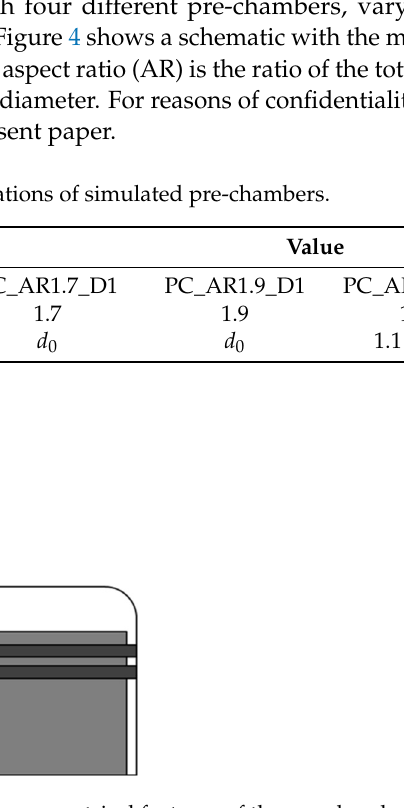
Figure 3. Detail of grid refinement in the spark plug region. Table 3. Mesh properties for the selected computational grid.